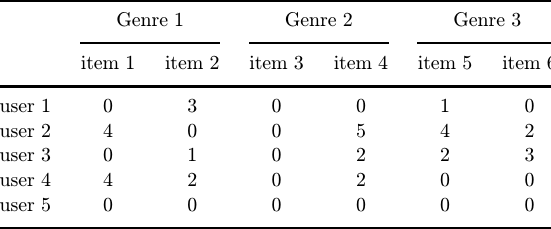
Table 4. Example of a user-to-item-to-genre